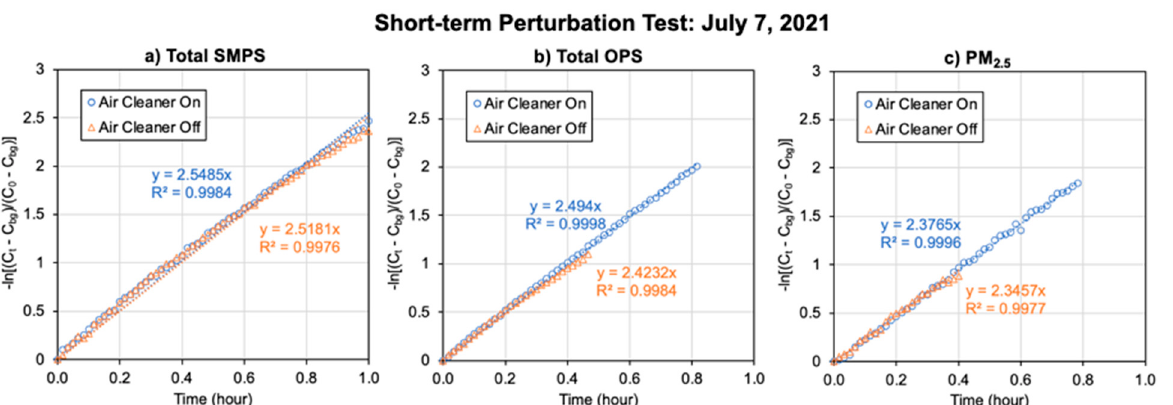
Figure 9. First-order particle loss rate constants ( λ + k ) from a short-term perturbation test (7 July 2021) after the air cleaner operated for a few hours and after the air cleaner was switched off: ( a ) total number concentrations measured by the SMPS (0.01–0.4 µm), ( b ) total number concentrations measured by the OPS (0.3–10 µm), and ( c ) estimated PM 2.5 mass concentrations.